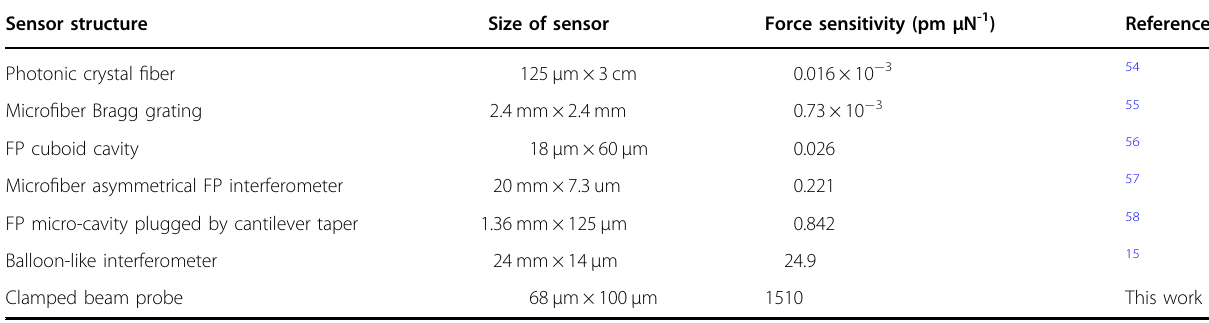
Table 1 Comparison of performance of fi ber sensors with different con fi gurations for micro-force measurements Sensor structure